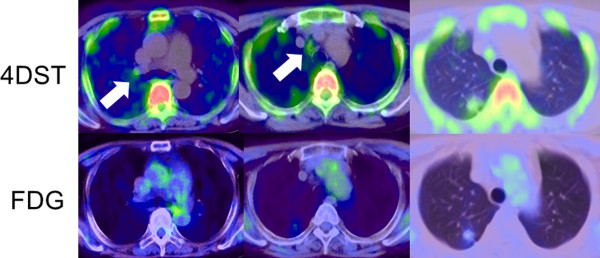
PET findings with 4DST and FDG for lymph node lesions and the primary lung cancer in patient no. 4. Mild but clear 4DST uptake is confirmed at the right hilar lymph node and the paratracheal nodes (#4R) (arrows).